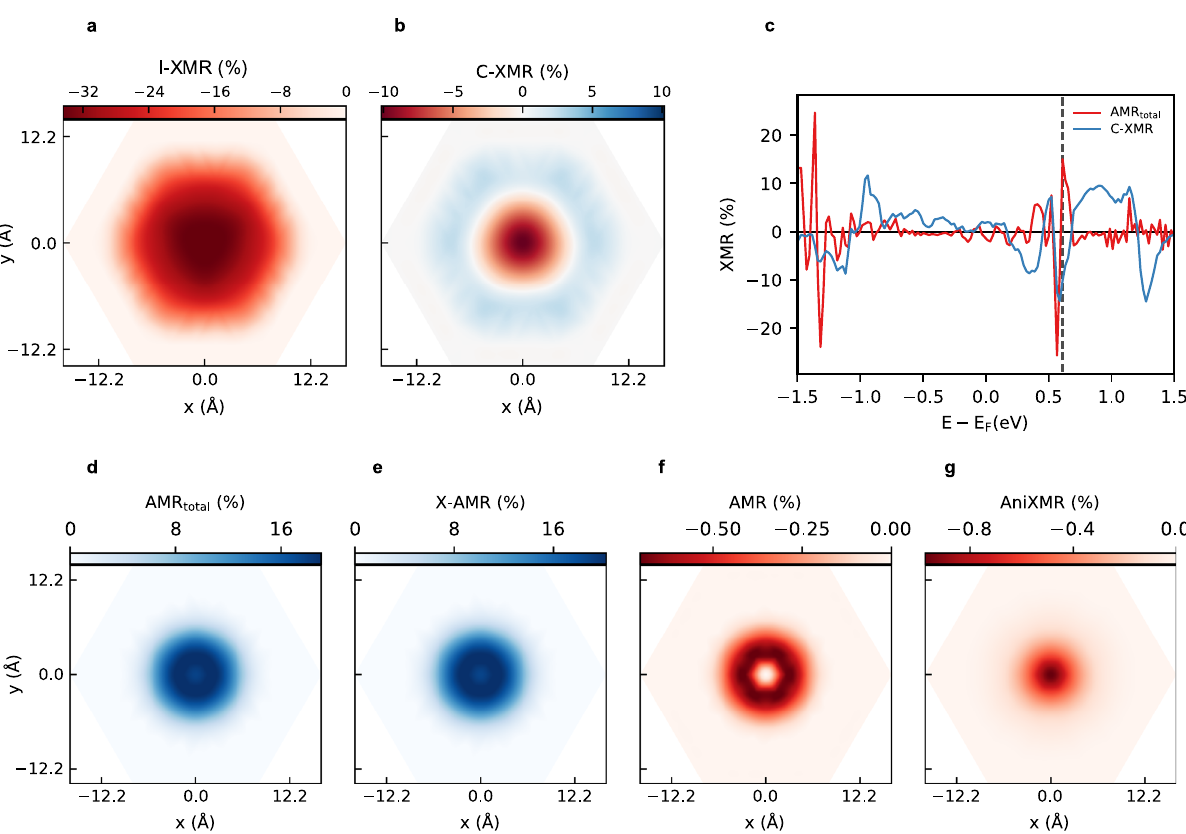
Fig. 4 Magnetoresistance patterns characterizing a Néel skyrmion. a , b Spin-orbit independent XMR pattern compared to the one emerging from C-XMR as obtained at the energy bias of eV bias = 0.61 eV. c Comparison of the energy-resolved C-XMR and total AMR ef fi ciencies measured atop the core of the skyrmion. The dashed line indicates the energy at which the two-dimensional maps are extracted. d Total AMR signal decomposed into the ( e ) X-AMR, ( f ) conventional AMR, and ( g ) ani-XMR